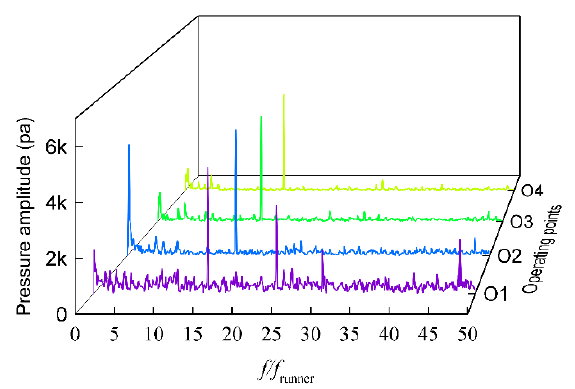
Figure 15. Spectral analysis of the pressure signals of V 1 in the vaneless space under the four di ff erent operating conditions.